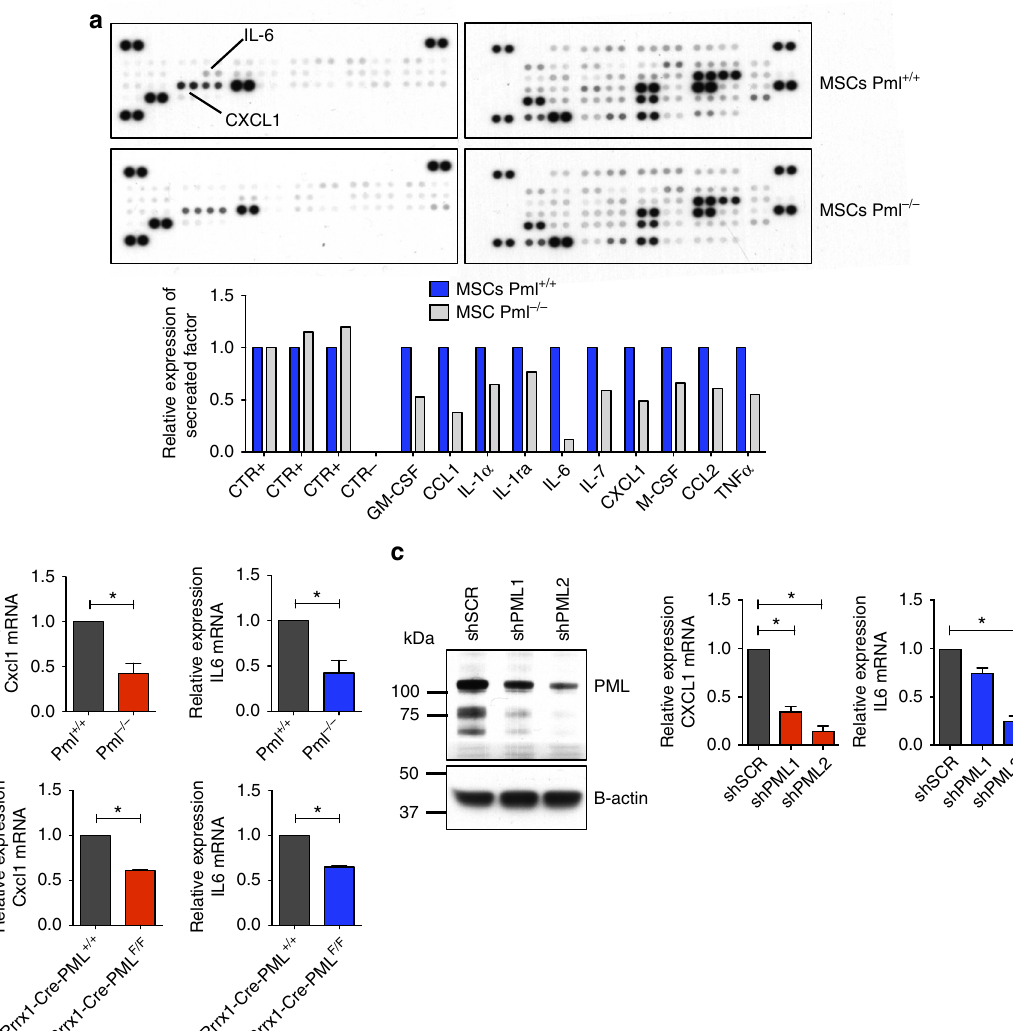
Fig. 5 Pml regulates pro-in fl ammatory cytokines in MSCs. a ELISA array for the detection of soluble factors and cytokines in the supernatant of MSCs Pml +/+ or Pml − / − . The quanti fi cation of signi fi cantly different factors is shown in the lower chart. b Relative expression of cxcl1 (charts on the left) and Il6 (charts on the right) in MSCs derived from Pml +/+ or Pml − / − mice (upper charts) or from Prrx1-Cre-Pml + / + and Prrx1-Cre-Pml F /F mice (charts at the bottom). Cells of n = 3 mice each group have been pooled before RNA extraction. Data are shown as average ± SEM. c Western blot showing the reduction of Pml expression in HS5 cells treated with two independent shRNAs against Pml is shown on the left; the expression levels of cxcl1 and Il6 in cells silenced for the expression of Pml is shown in the charts on the right. Data are shown as average ±